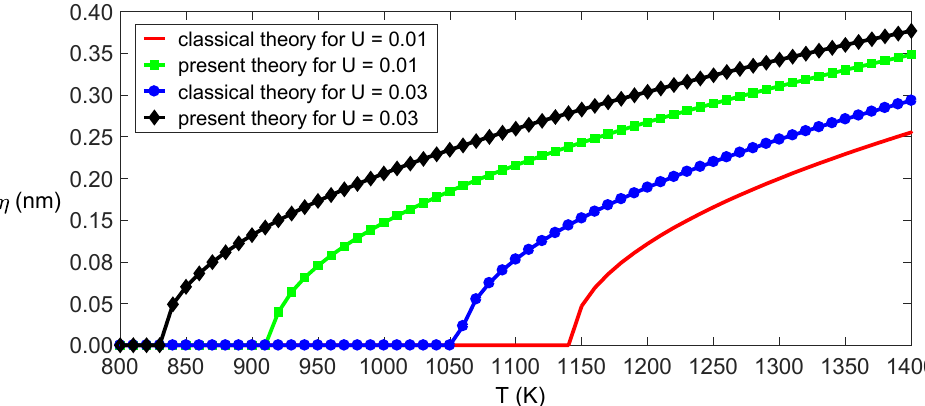
Figure 5. Amplitude of deformation as a function of temperature for the given electric fields.